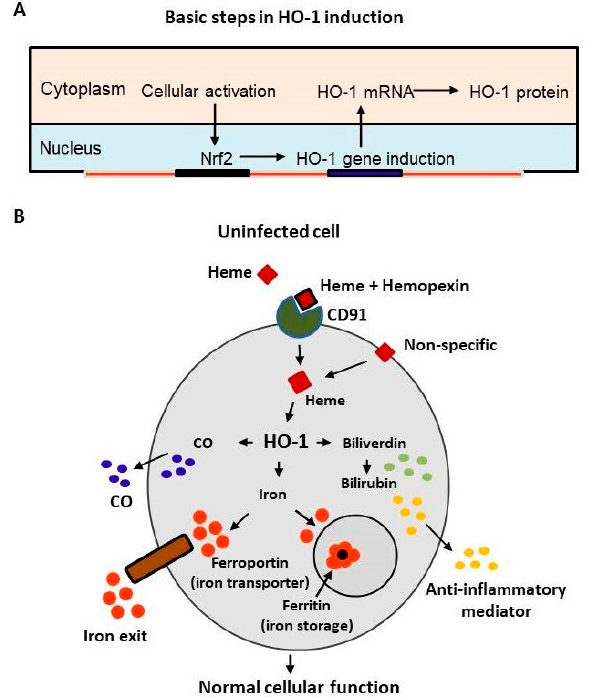
Figure 1. ( A ) Critical basic steps in the pathway of HO-1 regulation via its upstream transcription factor Nrf2 upon activation in response to extracellular signaling followed by translocation from nucleus to cytoplasm. ( B ) Diagram illustrating the involvement of HO-1 in iron homeostasis in normal cellular function, depicting HO-1-dependent hemoglobin and heme catabolic pathway. The activated HO-1 degrades hemoglobin and heme to biliverdin which is rapidly catalyzed by biliverdin reductase to bilirubin—a potent physiological mediator of the natural anti-inflammatory process.